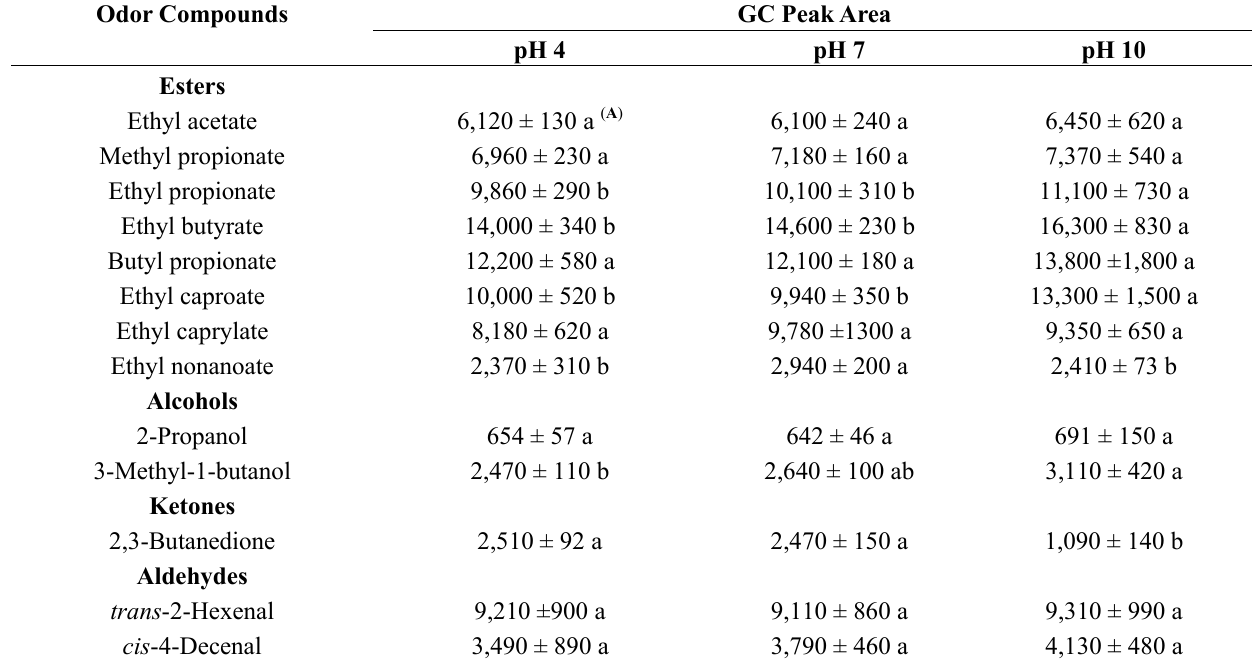
Table 3. Release of odor compounds in carboxylated cellulose hydrocolloid system adjusted to pH values of 4, 7, and